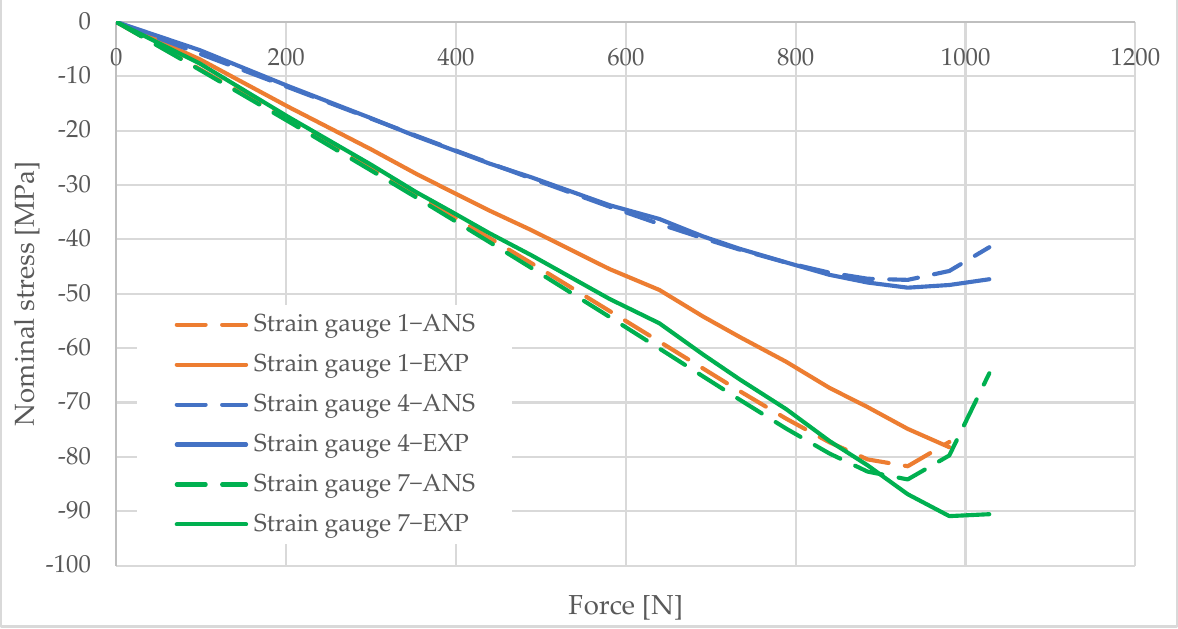
Figure 16. Pole 9/2 — values of normal stress readings from strain gauges no. 1, 4, and 7. Figure 16. Pole 9/2—values of normal stress readings from strain gauges no. 1, 4, and